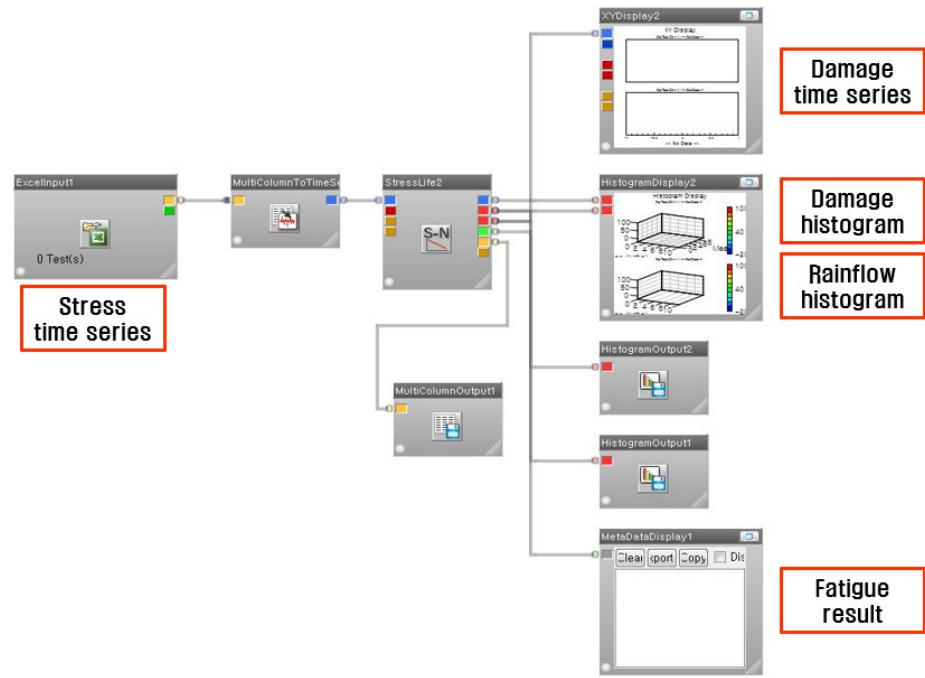
Figure 9. Fatigue life analysis process using nCode.